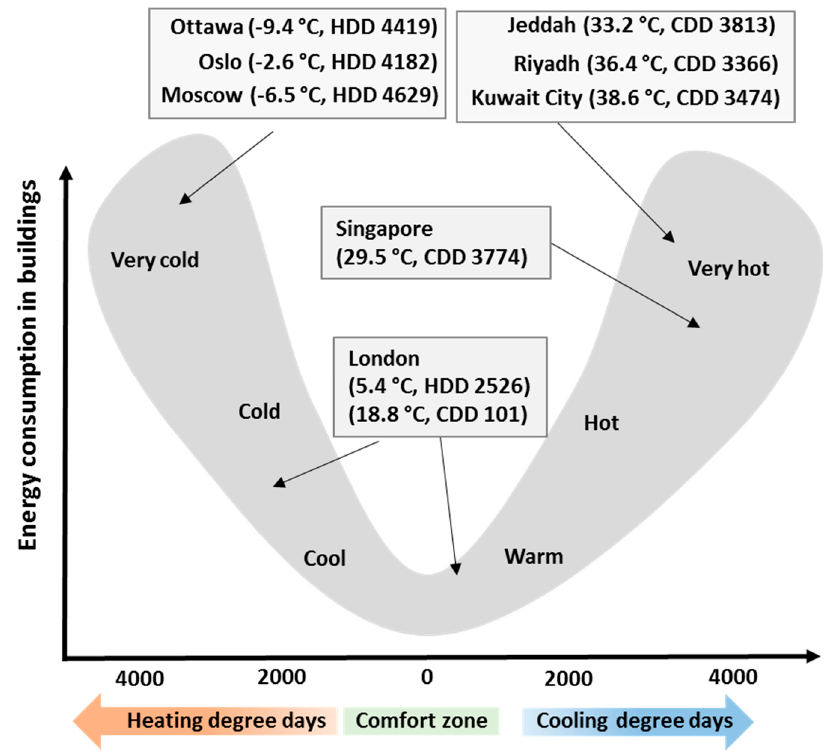
Figure 1. The relationship between energy and climatic conditions. Source: Authors based on ASHRAE climatic design conditions 2017 [27–29]. Note: The average temperature in the hottest or coldest months are shown alongside annual cooling and heating degree days for each city. The threshold comfort zone of cooling degree days (CDD) and heating degree days (HDD) is 18 °C.